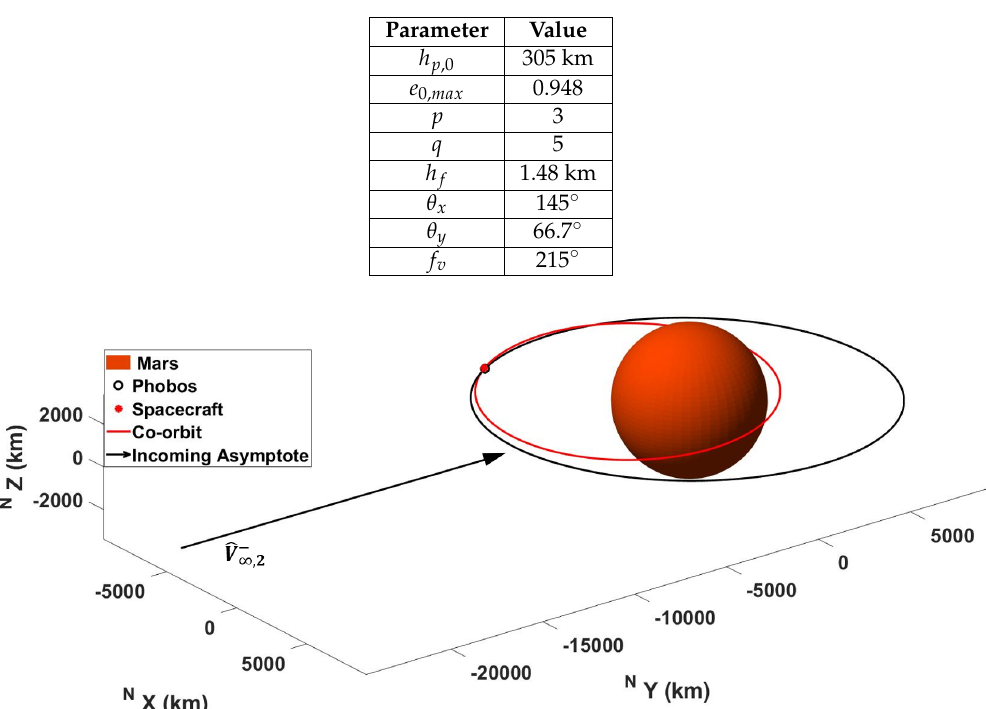
Table 8. Design variables constituting the selected optimal co-orbit design gene.